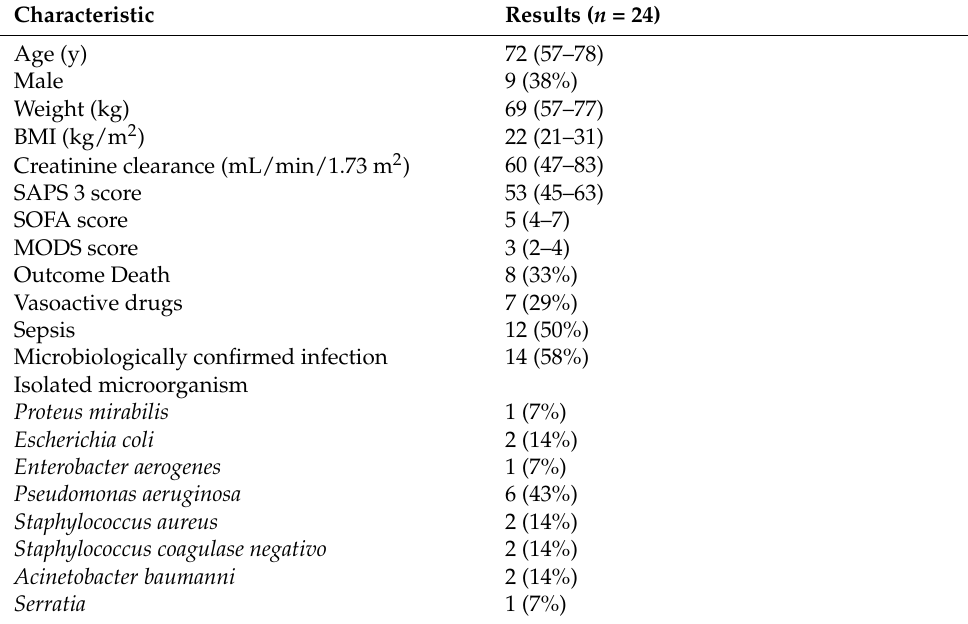
Table 1. Brazilian ICU patients’ demographic and clinical characteristics.